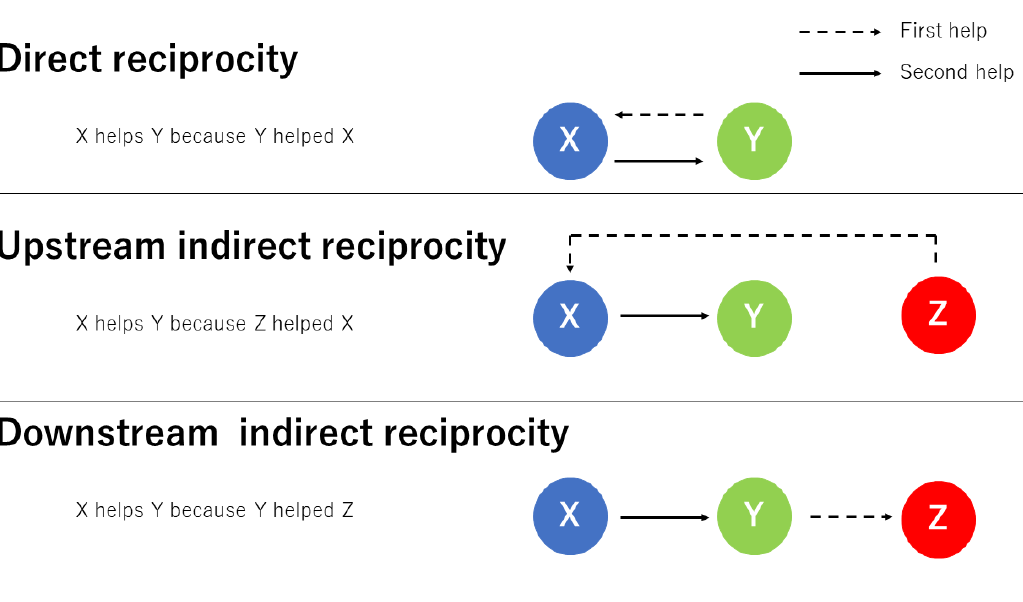
Figure 2. Basic mechanisms of direct and indirect reciprocity. This figure is based on Figure 1 of Nowak and Sigmund (2005)